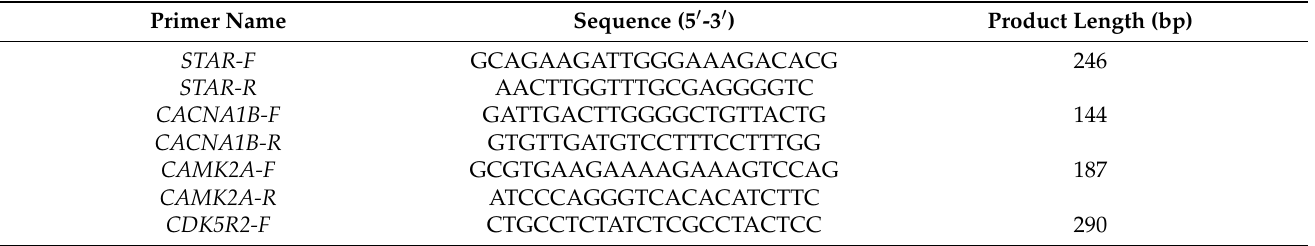
Table 1. Primers used in this